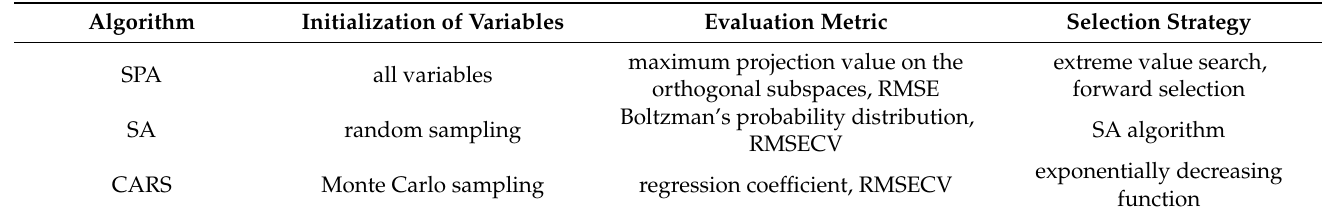
Table 1. The three factors and characteristics of wavelength dimensionality